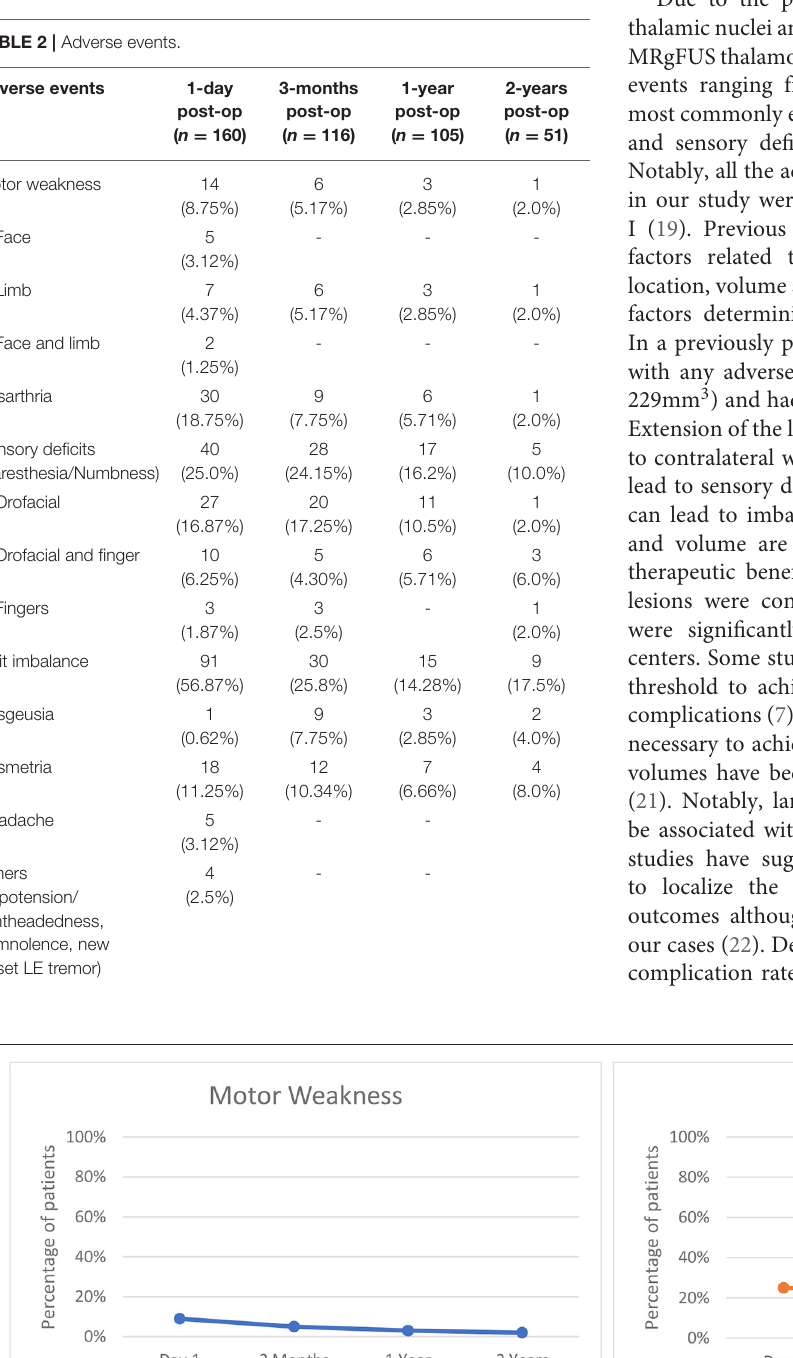
Frontiers in Neurology |